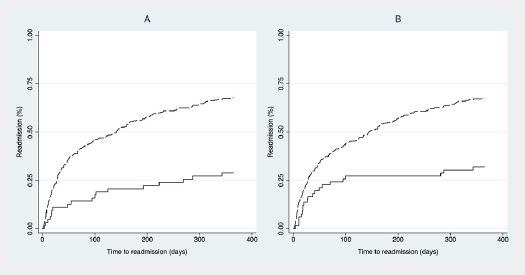
Kaplan-Meyer estimations curves for readmission stratified by the Identification of Senior at Risk (ISAR) and by the Triage Risk Stratification Tool (TRST). A: ISAR <2 (plain line) - ISAR ≥2 (long-dash line), logrank test: p